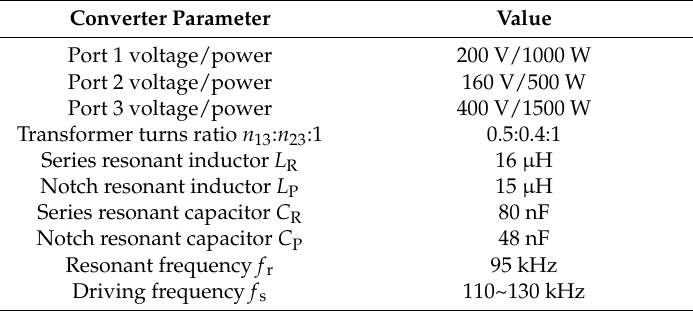
Table 1. Parameters of the proposed system.